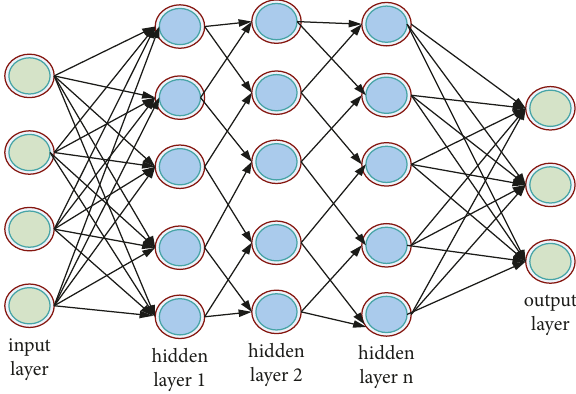
Figure 2: Multilayer neural